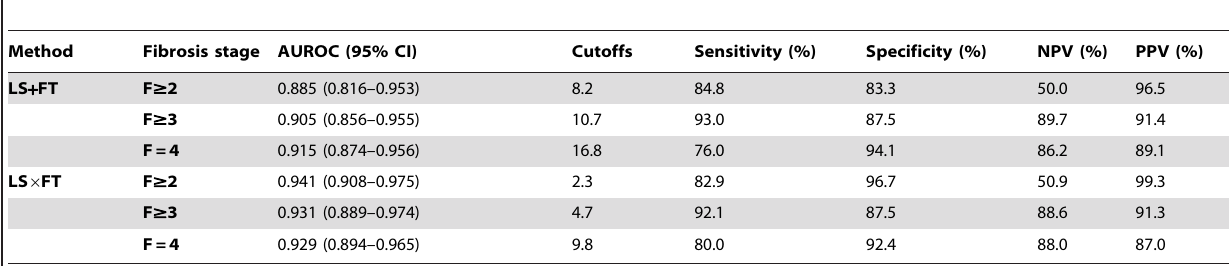
Table 5. Diagnostic performances of combination formula using LS and FT and their suggested optimal cutoff values.